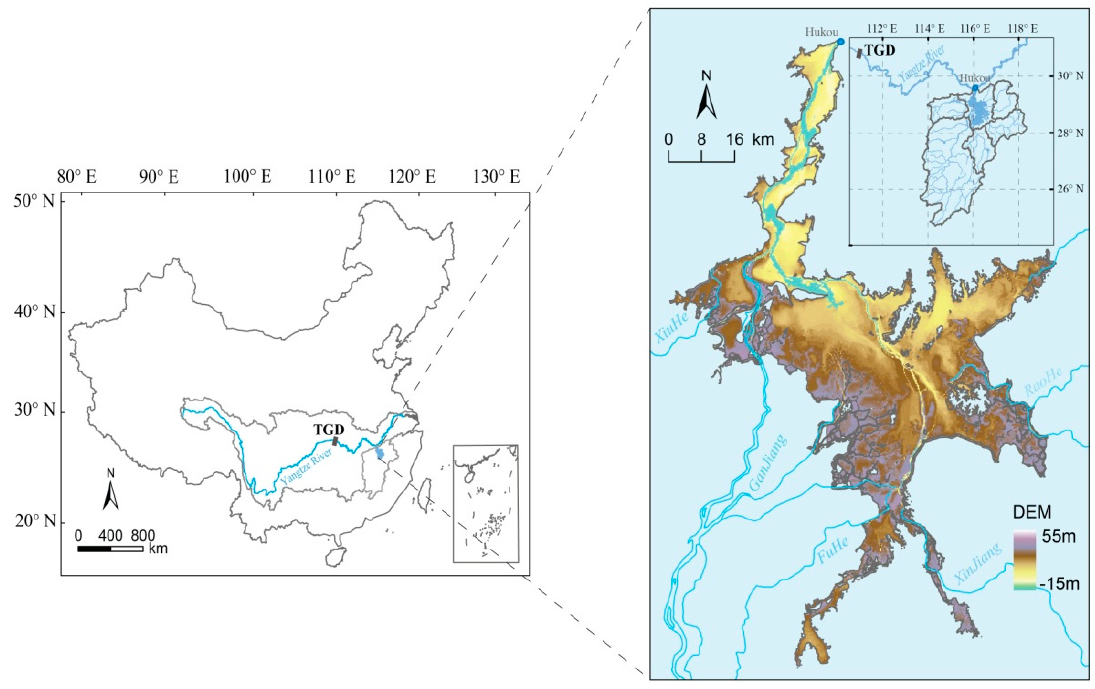
Figure 2. Geographical location of the Poyang Lake wetland and the Three Gorges Dam (TGD) in China.